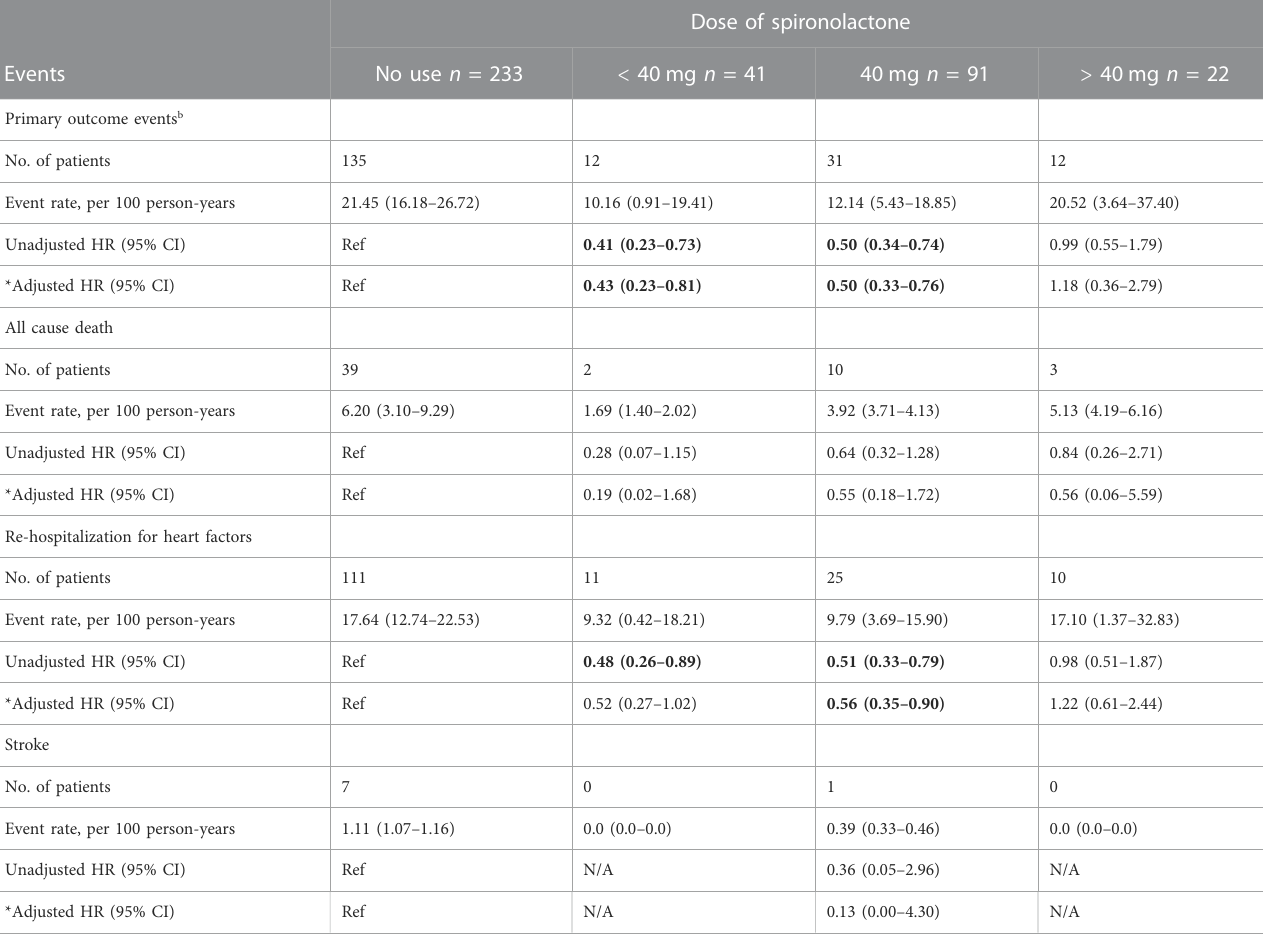
TABLE 4 Primary outcomes events in patients categorized according to the dose of spironolactone (Risk estimates calculated using no-use as reference) a . Dose of spironolactone